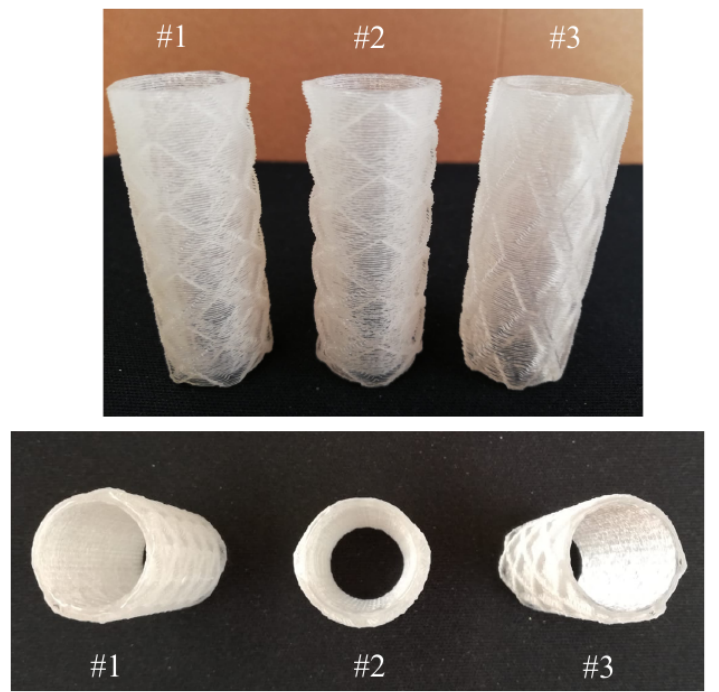
Figure 3. Stent prototypes printed by ACEO and used for the experimental compressive tests: #1 prototype, #2 prototype, #3 prototype.